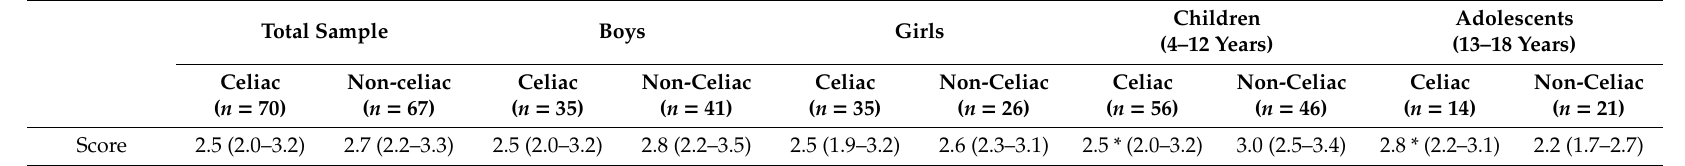
Table 12. Physical activity scores for celiac and non-celiac children and